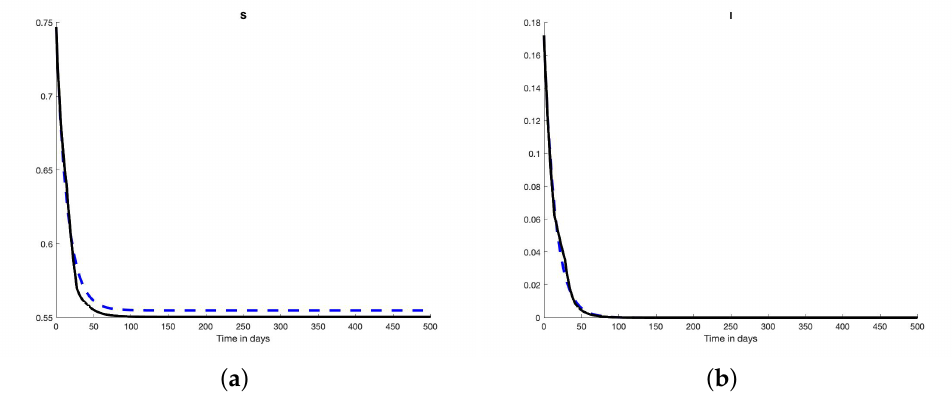
Figure 16. Scenario 6: States. ( a ) S and S ∗ (- -); ( b ) I and I ∗ (-